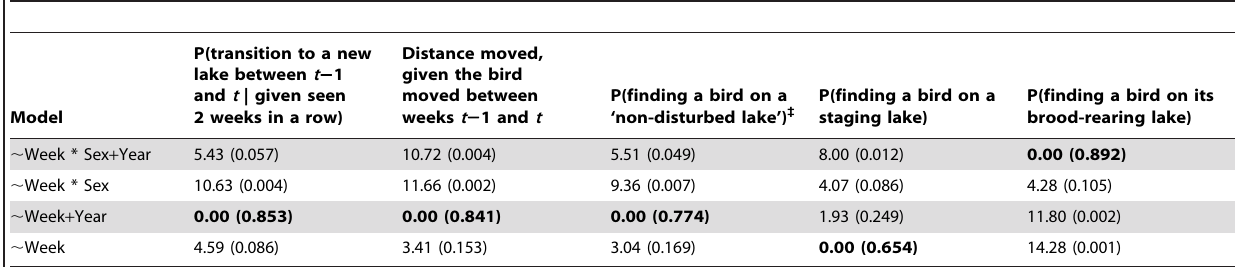
Table 2. Summary of D QIC * measures (model weights { ) associated with generalized estimating equation (GEE) models fit to each of 2 movement-based response variables and 3 wetland characteristics response variables.